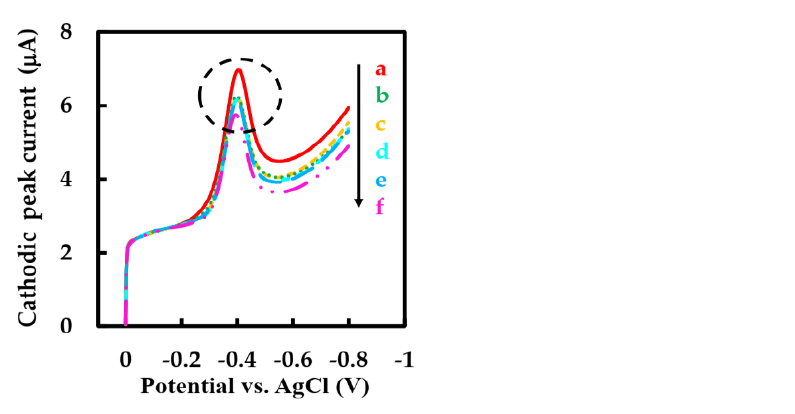
Figure 9. LSVs of NF-GLA/MWCNTs-BSA-HFs-GOD/GCE in blank phosphate-buffered solution ( a ), 1 mM Glu solution ( b ), and Glu solution containing 0.1 mM Vit B 1 ( c ), Vit B 1 + Vit C ( d ), Vit B 1 + Vit C + NaCl ( e ), and 1.5 mM Glu solution ( f ) in air-saturated 50 mM phosphate-buffered solution (pH 6) at a scan rate of 0.05 V ‧ s −1 .